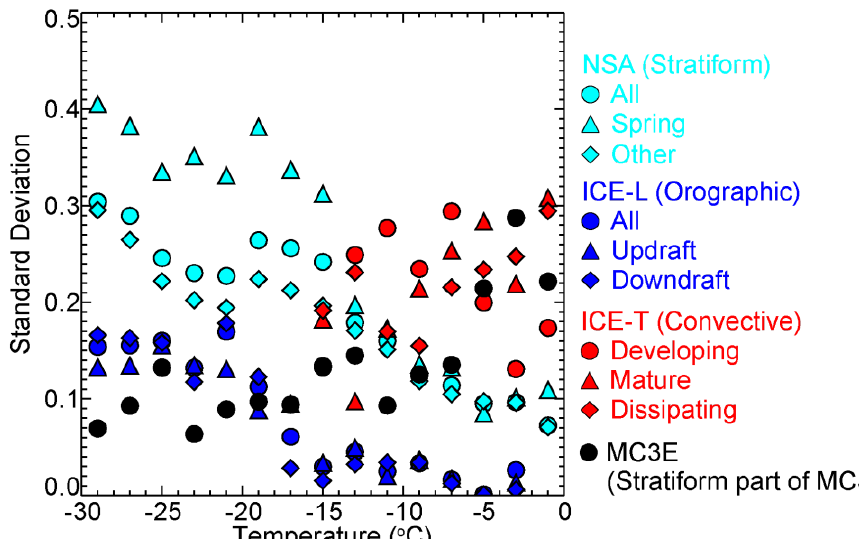
Figure 7. Standard deviations of the liquid fractions for stratiform mixed-phase clouds sampled at the NSA site, orographic mixed-phase clouds sampled in ICE-L, tropical maritime convective clouds sampled in ICE-T, and stratiform parts of MCSs sampled in MC3E.